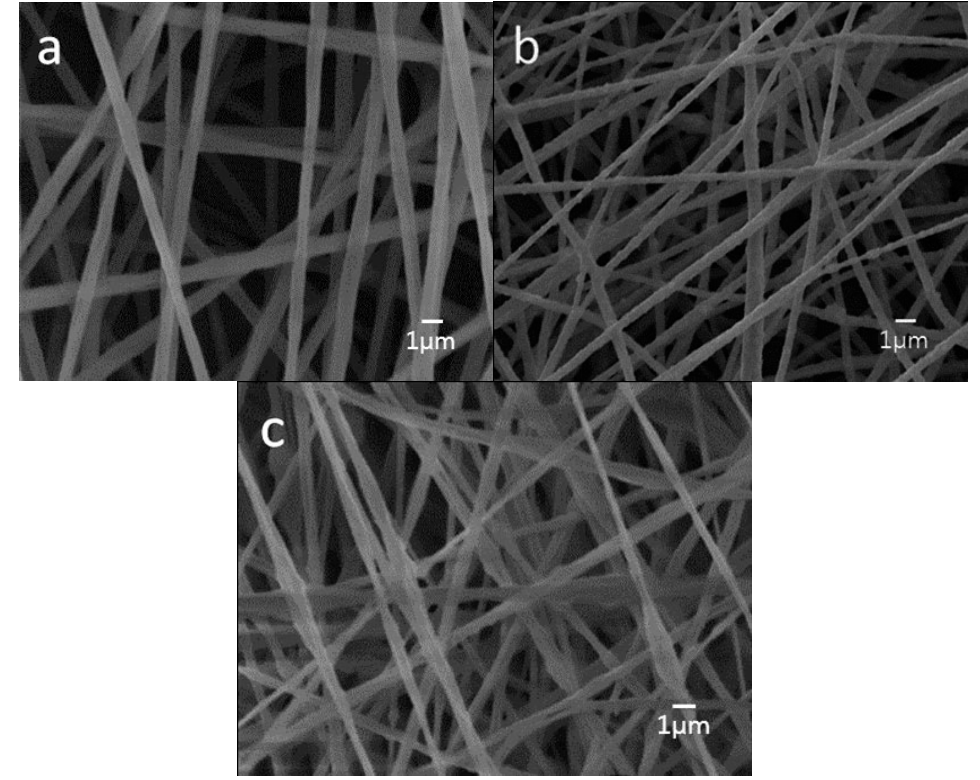
Figure 4. SEM micrographs of electrospun ( a ) PLA, ( b ) PLA/15%nHA and ( c ) PLA/15%nHA-3%GO fibrous mats. Table 1. Average diameter and porosity of electrospun PLA and its nanocomposite fibrous mats.